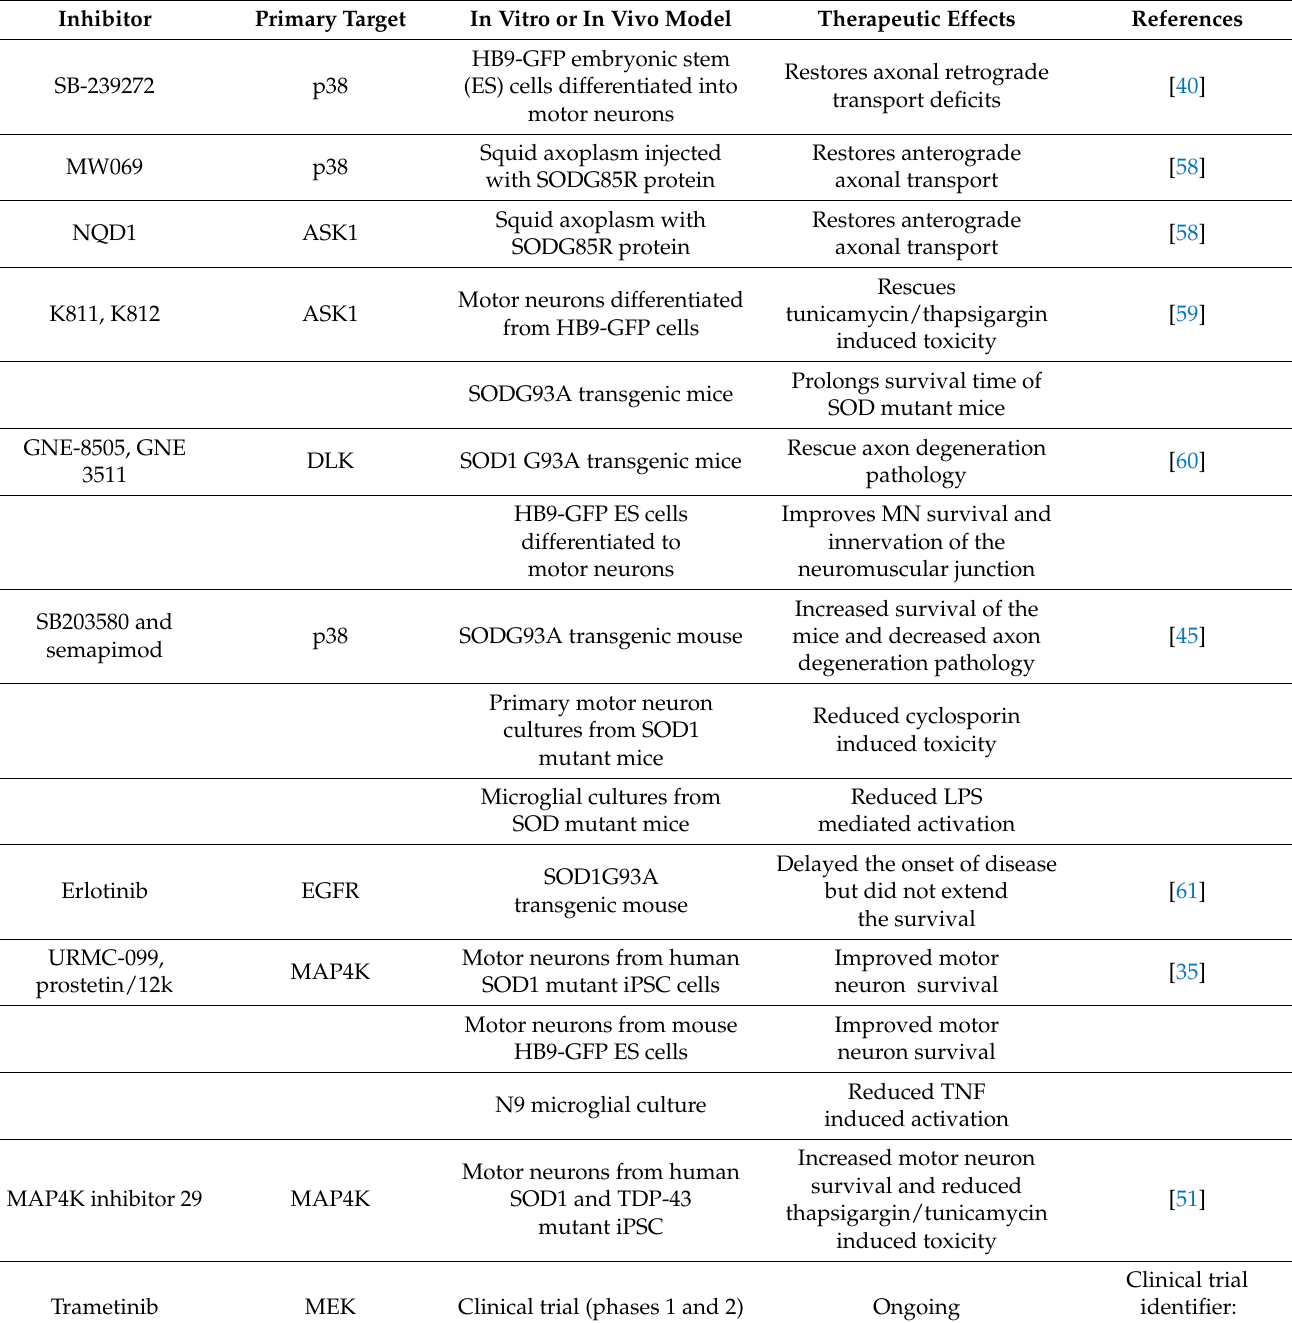
Table 2. List of MAPK inhibitors tested for ALS in various disease